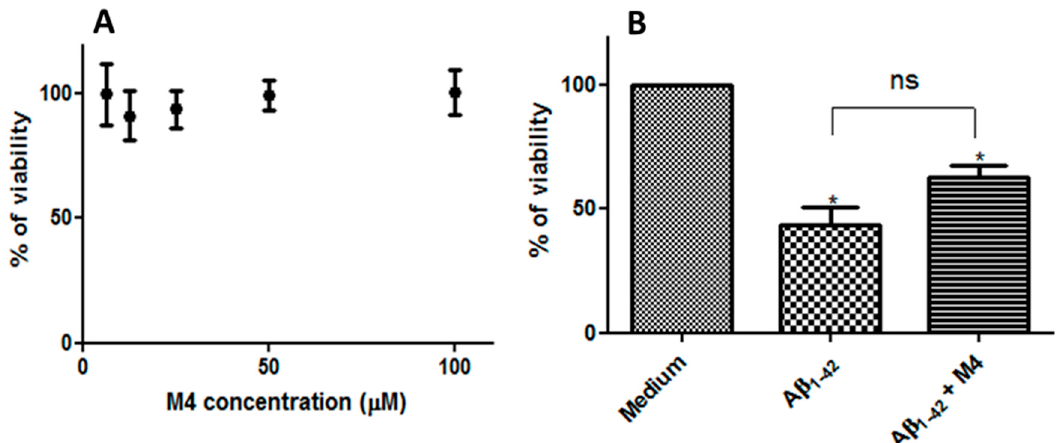
Figure 3. Viability of astrocyte cells from primary cultures among several treatments after 48 h of incubation, calculated by the 3-(4,5-Dimethylthiazol-2-yl)-2,5-Diphenyltetrazolium Bromide (MTT) assay. ( A ) Astrocyte viability in the presence of several concentrations of M4 . The experiment was done in triplicate with n = 8. ( B ) Astrocyte activation with 30 µ M A β 1-42 peptide and the protective e ff ect of the M4 compound at 100 µ M. The experiment was done in triplicate with n = 3. Statistical di ff erences were calculated by one-way ANOVA, followed by Tukey’s test, and considering significant di ff erences with * p < 0.05, (between medium and treatments).